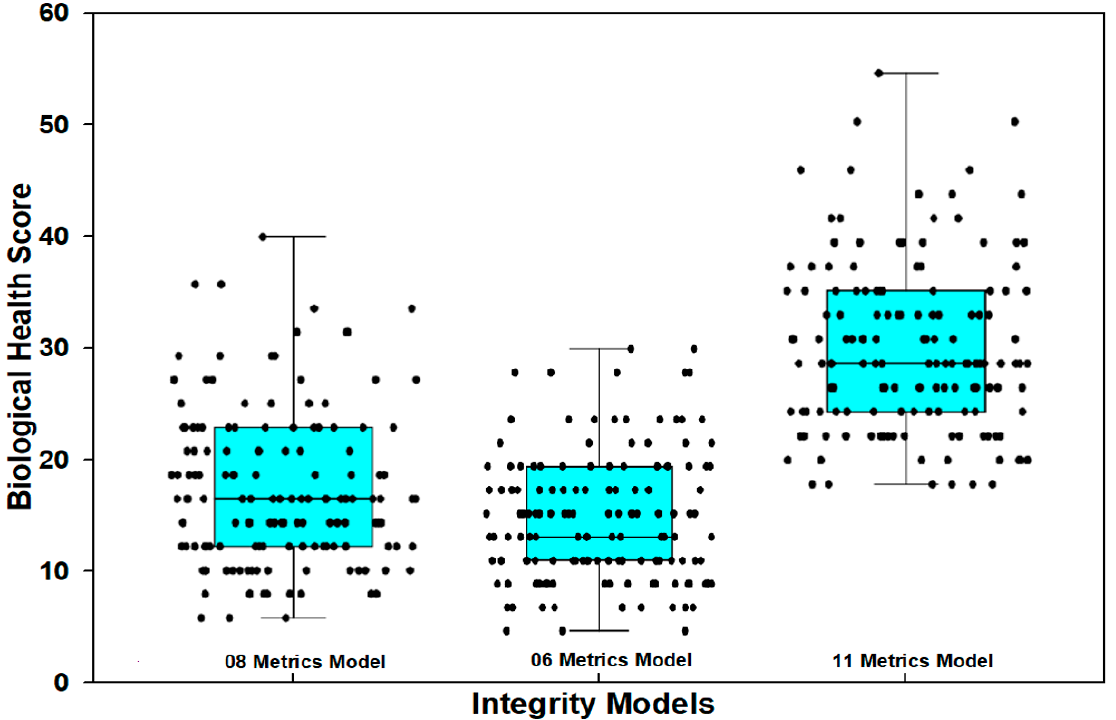
Figure 6. Box and jitter plot showing the spatial distribution of study sites based on biological health according to three models in Geum River watershed.